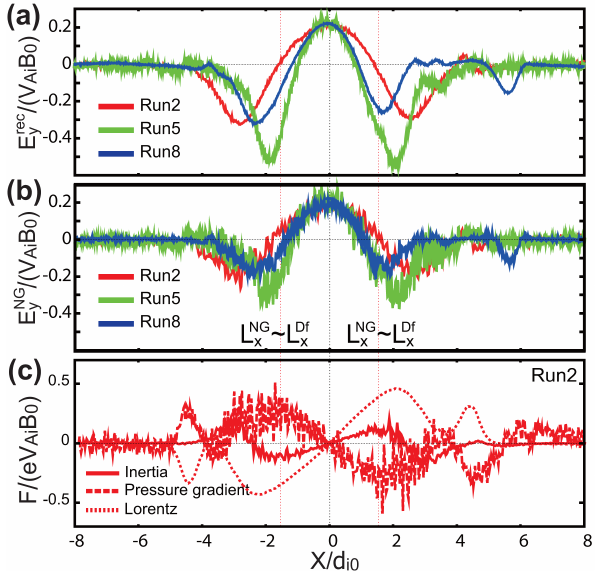
− 1 / 2 e for Runs 2 (red),